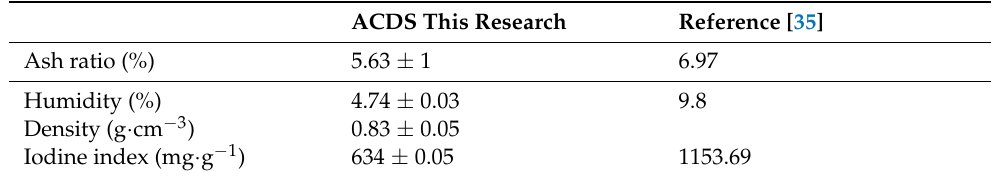
Table 3. Results of physical parameters, iodine index of ACDS.